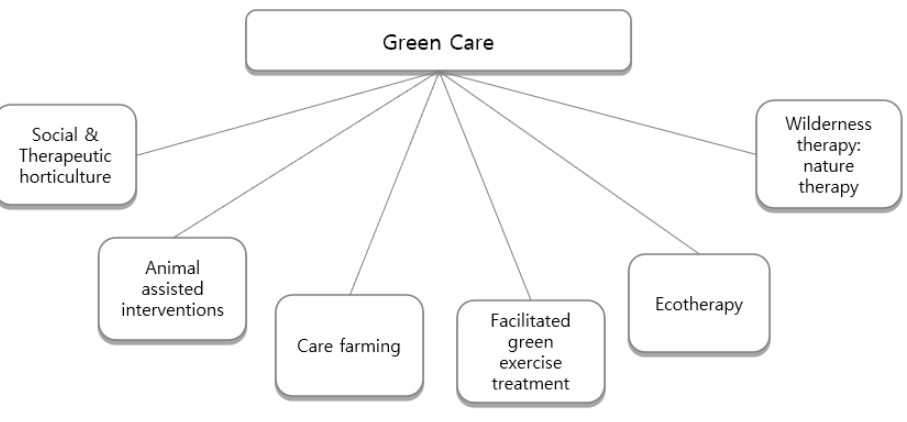
Figure 1. Green care areas: Green care umbrella (Source: Sempik 2010).